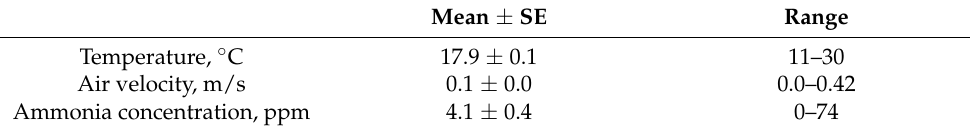
Table 5. Descriptive data for temperature, air velocity, and ammonia